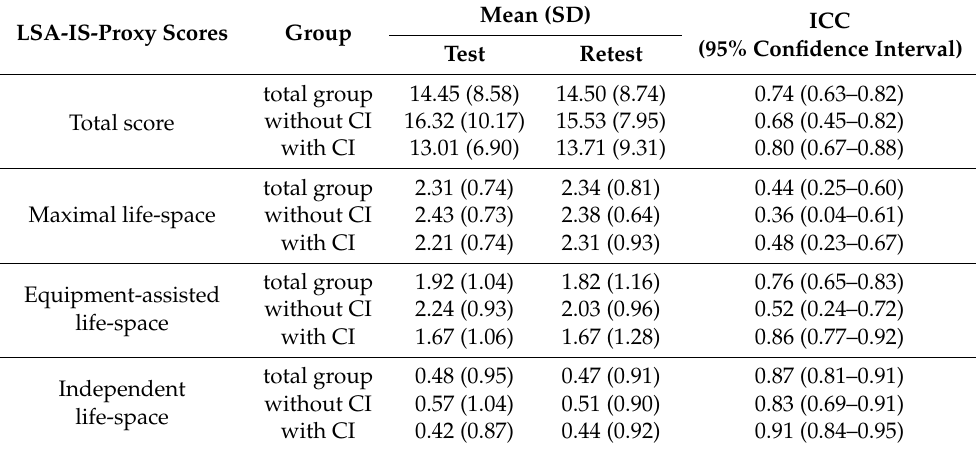
Table 4. Test–retest reliability of the